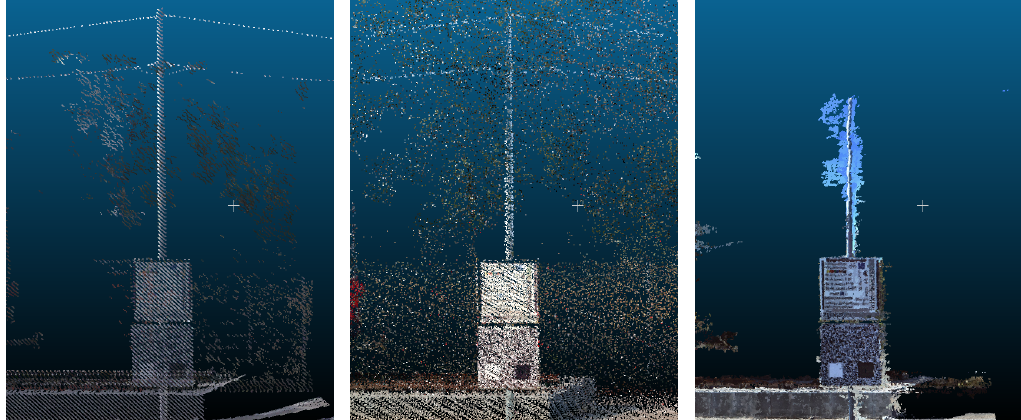
Figure 6. Point clouds of the test chart at a distance of 5m. From left to right: System A, B, C. Table 1. Performance parameters of imaging quality at test charts in different orientation at distances of minimum 10m and 5m, respectively, for 3 different mobile mapping systems. The letters ‘h’ and ‘v’ denote the direction of the scale bar, together with the bar length in mm. The @-Symbol denotes that for a certain mobile mapping system the data acquired at a certain distance is analyzed. Legibility Pixelsize ∆ [mm] Line Pair Width w [mm] System forw.